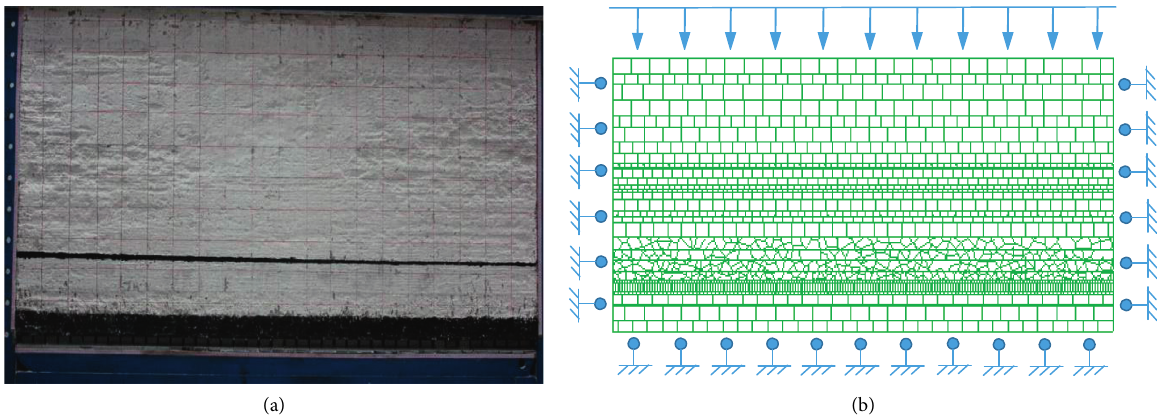
Figure 1: Schematic diagram of the coal and rock model of the working face. (a) Physical model. (b) Numerical